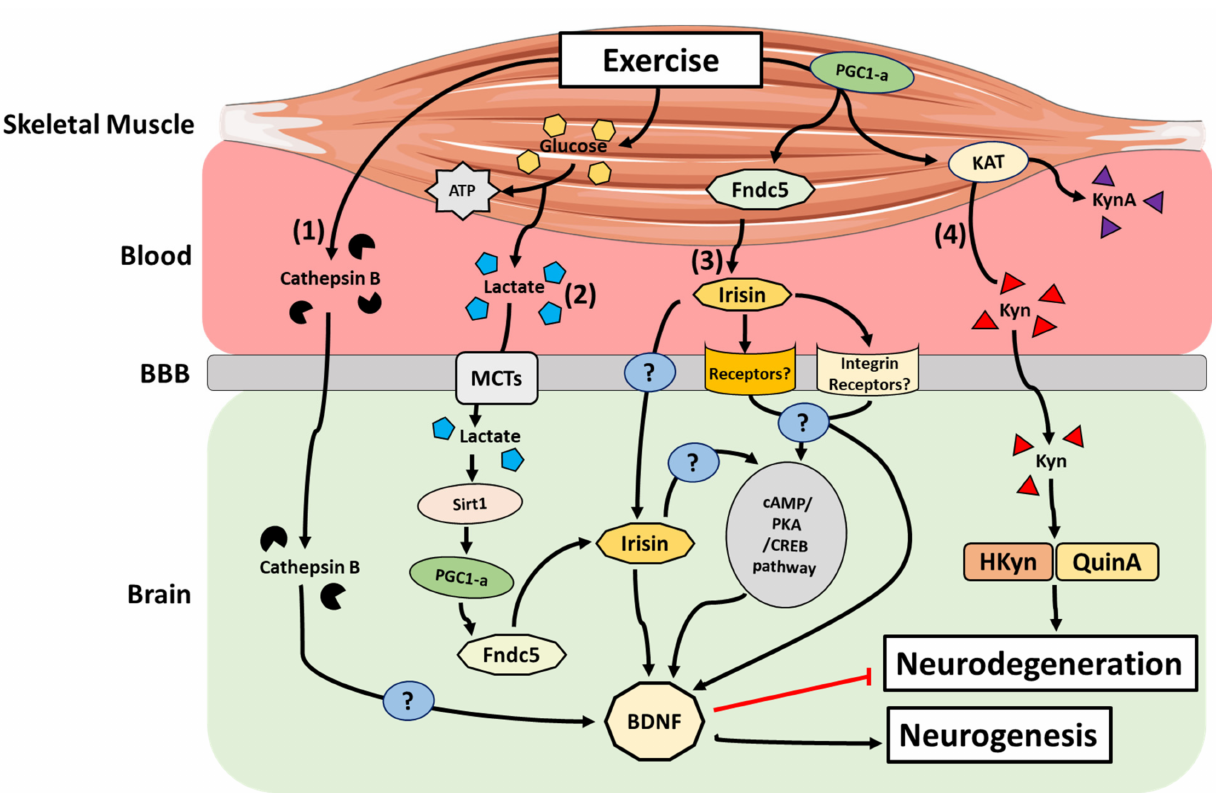
Figure 2. Main mechanisms by which active skeletal muscle can impact the brain. (1) Cathepsin B transcription is upregulated in brain and skeletal muscle, and its concentration increases in the blood in response to exercise. Cathepsin B is able to cross the BBB and may induce BDNF transcription in hippocampal neurons. (2) During exercise, glycolysis converts glucose into pyruvate to produce ATP. Lactate is produced from this reaction and accumulates in the blood. Lactate can cross the BBB and activate the PGC1 α /FNDC5 signalling pathway and promote BDNF expression. (3) Exercise increases the release of irisin into the circulation. Irisin can cross the BBB and/or trigger several signalling pathways (including the cAMP/PKA/CREB) to activate BDNF production. (4) Kynurenine aminotransferases are increased in ‘trained’ skeletal muscles. These enzymes convert Kyn into kynurenic acid (KynA). Consequently, peripheral Kyn-to-KynA conversion is increased and prevents the accumulation of Kyn and its related neurotoxic metabolites (3-hydroxykynurenine or quinolinic acid) in the